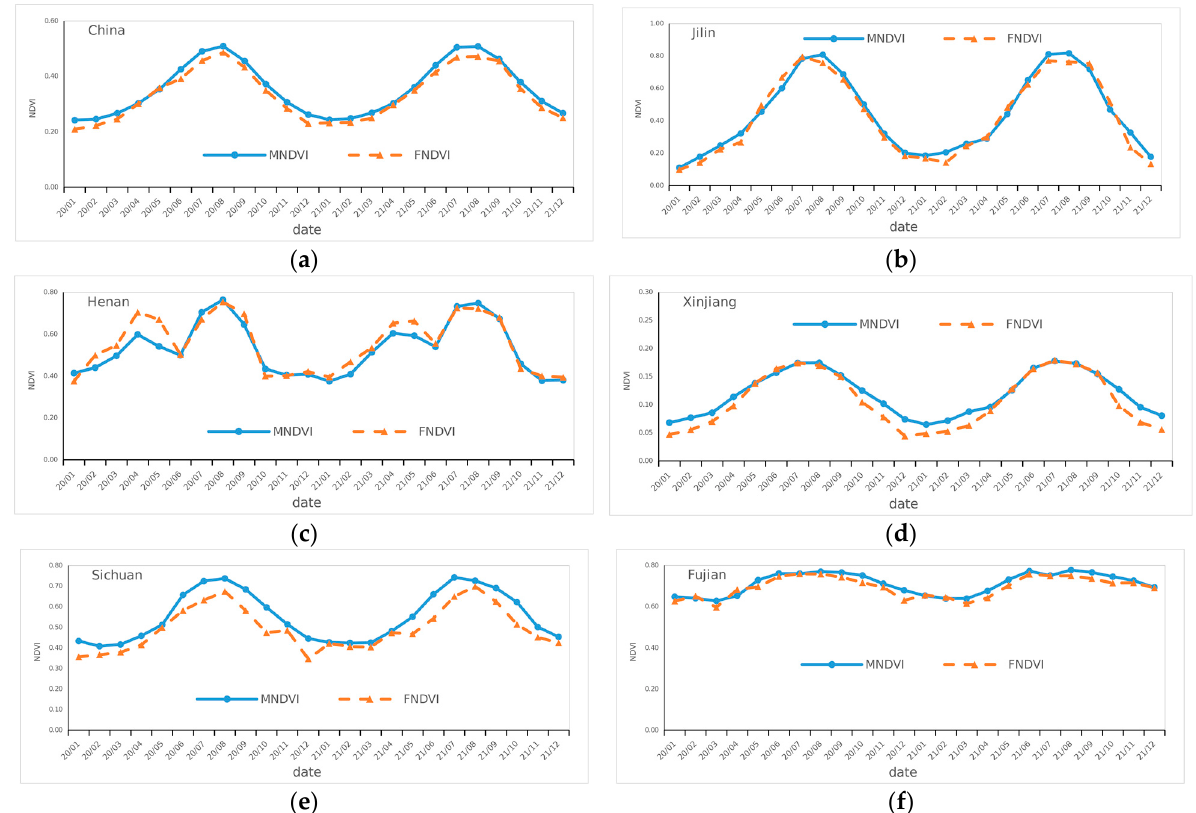
Figure 8. Comparison of the regional average real sequence of monthly FNDVI and MNDVI values in China from 2020 to